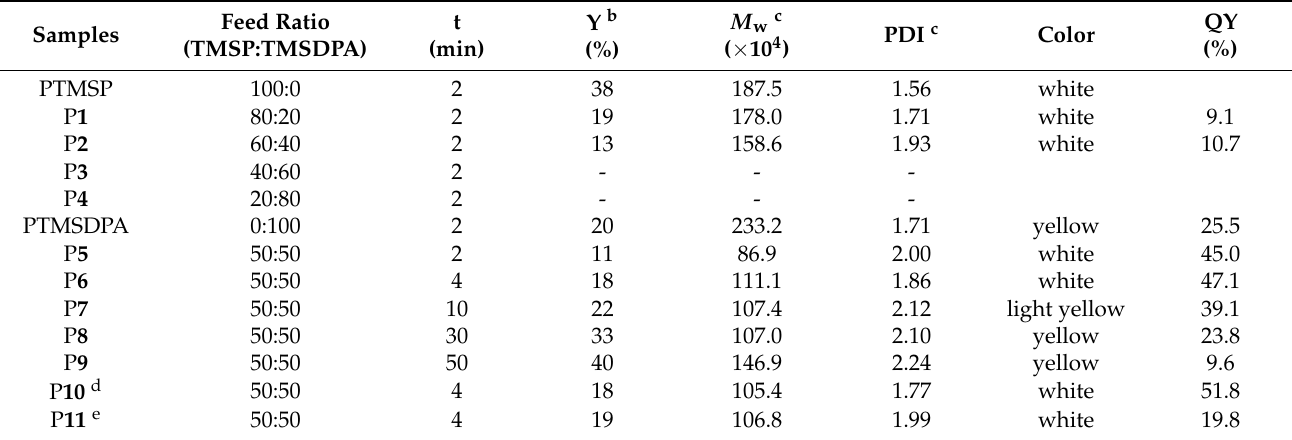
Table 1. Copolymerization of TMSP and TMSDPA a